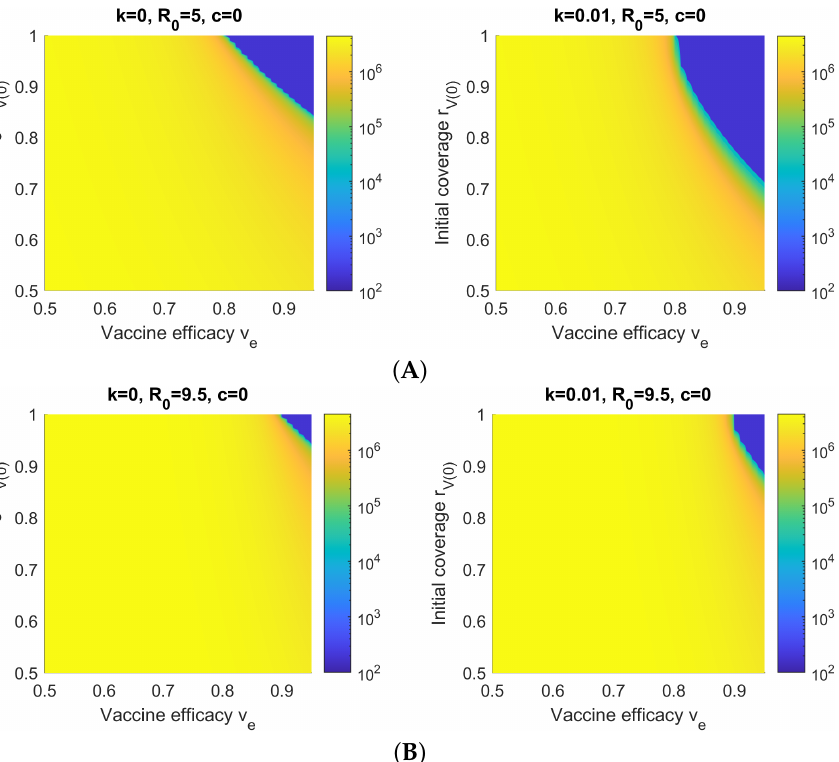
Figure 6. Cumulative hospitalizations/isolations H c ( ∞ ) with respect to the initial vaccination cov- erage r V ( 0 ) and average vaccine efficacy v e for simulated ( A ) Delta and ( B ) Omicron outbreaks and no NPIs ( c = 0). The area of the blue region, representing a low number of total infec- tions/hospitalizations, increases with k , the vaccination